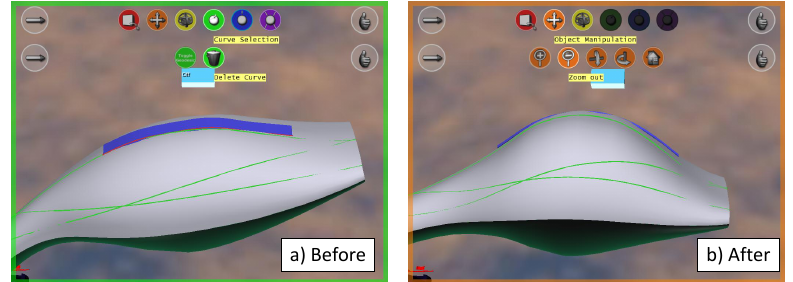
Figure 13. Global modification task performed an a